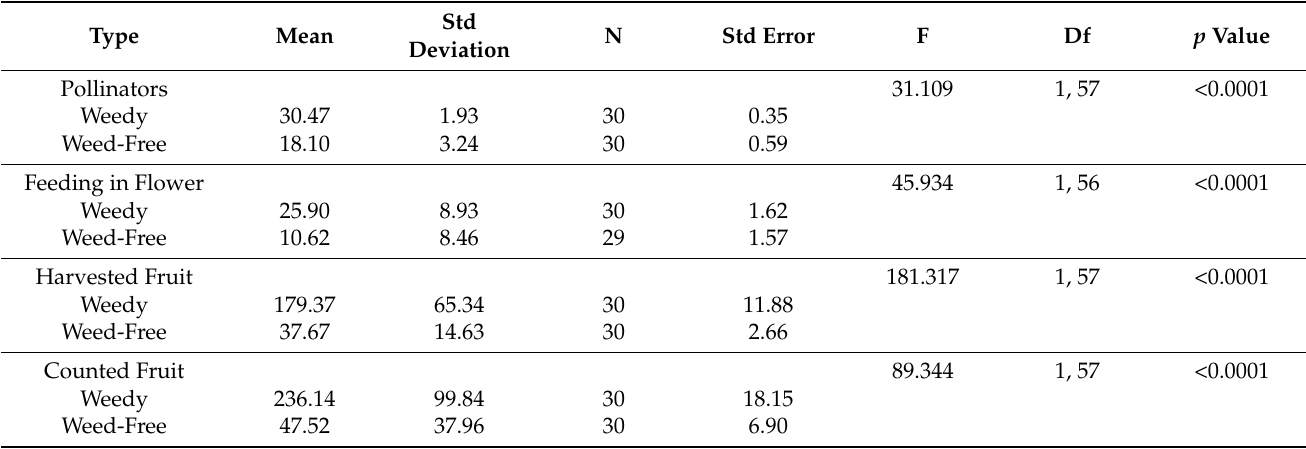
Figure 2. Mean Number of pollinating insects on mango by treatment ± SE. Significant difference indicated above each table. **** p ≤ 0.0001. Table 1. Pollinators and fruit yield on mango trees growing with or without weeds. Significant differences as shown by GLM Multivariate ANOVA (MANOVA) have p values in